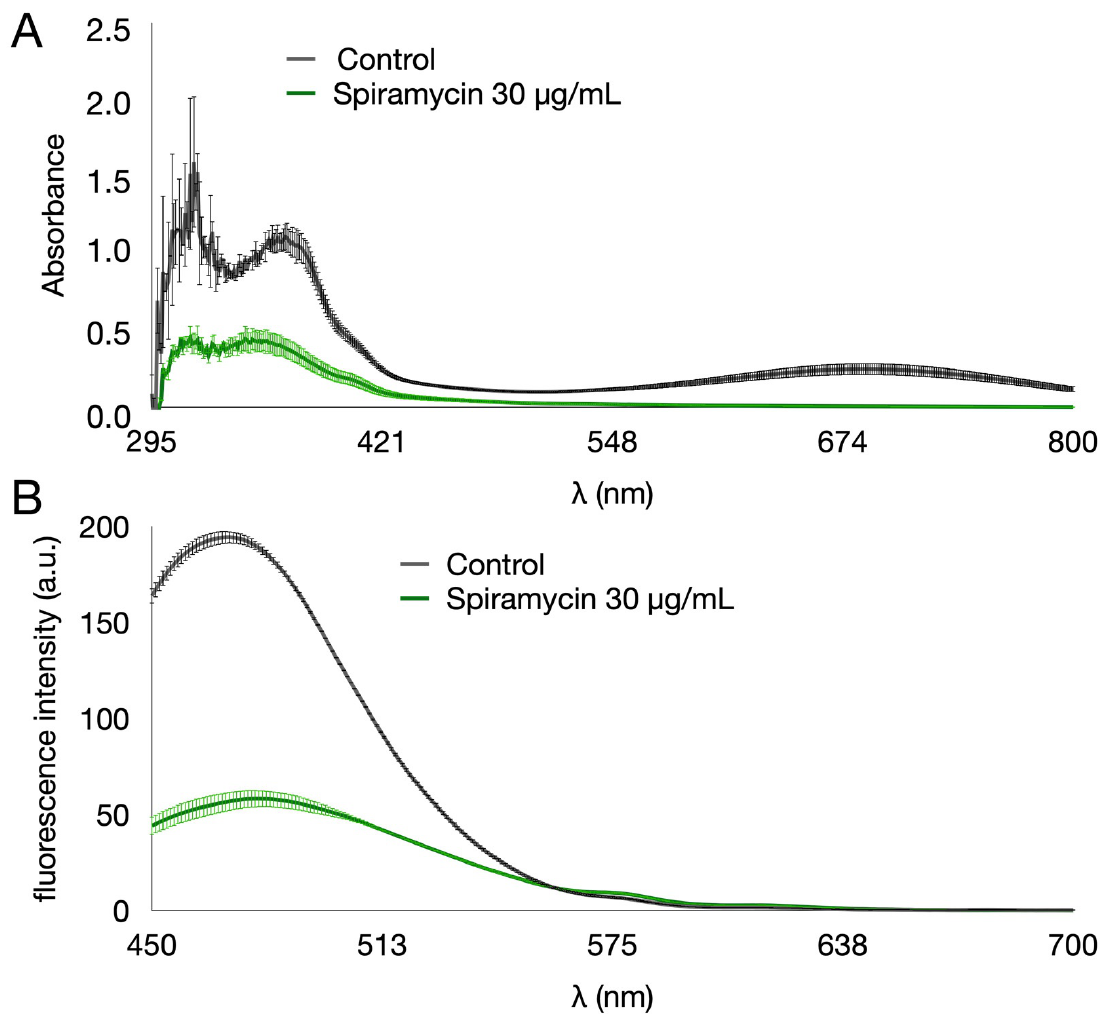
Figure 2. Absorption and fluorescence emission spectra of the exhausted LB broth of P. aeruginosa GG-7R grown either in the absence or in the presence of spiramycin (30 μ g/mL). ( A ) Absorption spectra and ( B ) fluorescence emission spectra (excitation at 405 nm) of exhausted LB from P. aeruginosa cultures in multiwell plates. The samples were collected after the MIC experiment. The LB broth was diluted by 1 to 200 prior to measurement. The bacterium was grown at 37 °C and 180 rpm for 24 h. The phenotype of bacteria growing at sub-MIC concentrations of spiramycin or ery- thromycin was evaluated on LB agar plates (Figure 3A,B). After 24 h of growth, spi- ramycin did not affect bacterial growth at all tested concentrations (30, 60, 90, 120, 150, and 180 µ g/mL). However, production of greenish pigmentation was markedly reduced (Figure 3A). The ability of spiramycin (120, 150 and 180 µ g/mL) to inhibit pigment produc- tion without inhibiting bacterial growth was even more evident after 48 h of incubation (Figure 3B). After 48 h (72 h, 96 h, and 120 h) no changes were detectable in the plate with spiramycin at 120, 150 and 180 µ g/mL. However, this effect could also be related to the fact that the bacterial culture is in the stationary phase after 24 h. Production of greenish pigmentation was also markedly reduced in erythromycin-exposed bacteria after 24 h of incubation. However, bacterial growth was clearly inhibited at erythromycin concentra- tions of 30, 60, and 90 µ g/mL, and markedly inhibited at erythromycin concentration of 120 µ g/mL or higher (Figure